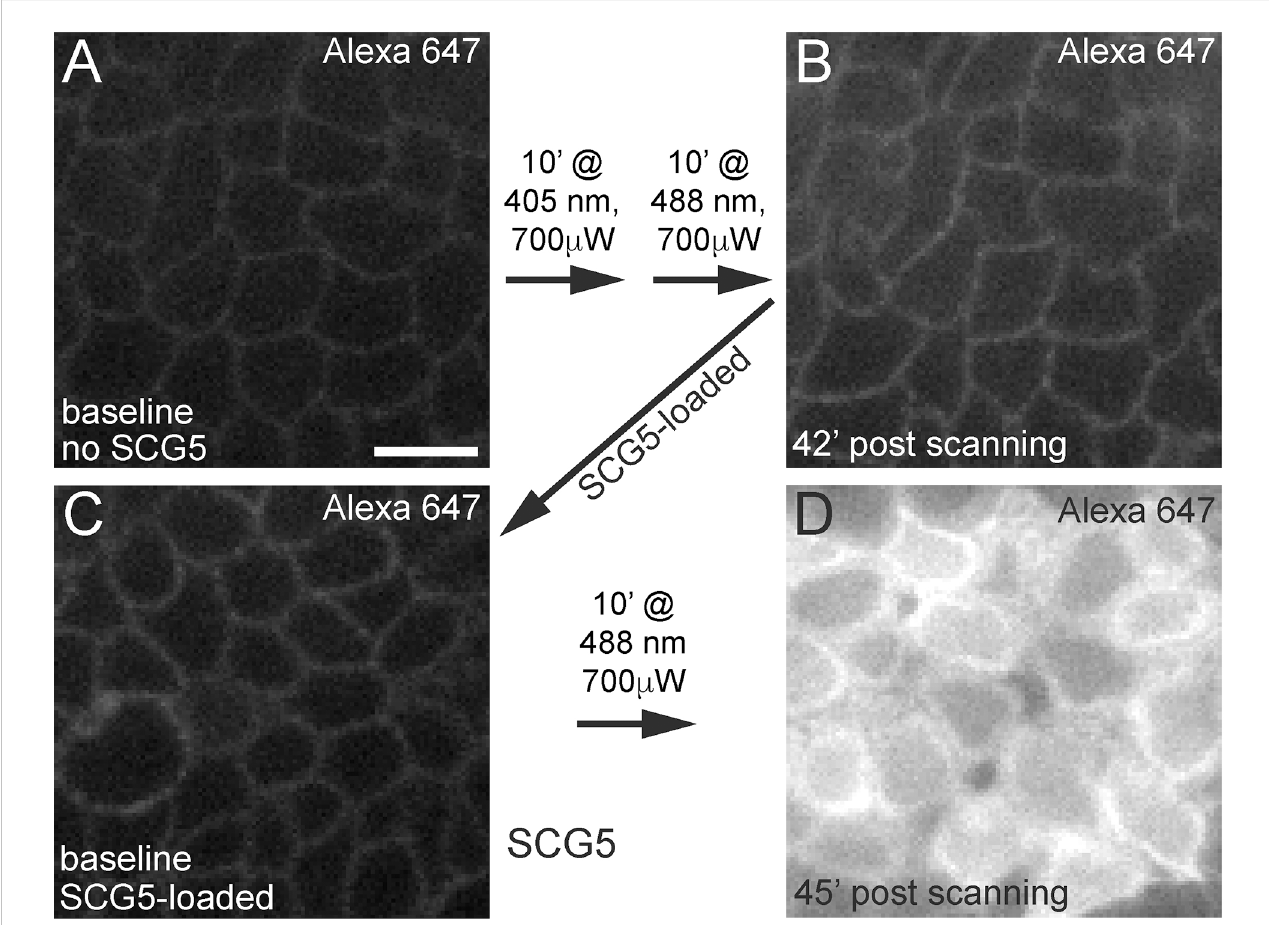
FIGURE 5 Confocal laser scanning-induced corneal microdamage is dependent on SCG5. Alexa 647 hydrazide injected eyes in the absence (A, B) or presence (C, D) of SCG5 were subjected to the wavelengths, laser powers and durations indicated on the arrows. At all other times, imaging was performed using the 640 nm laser line set at <5% laser power. (B) Scanning for 10 ’ at 405 nm (80% laser power setting, 225 m W) followed by another 10 ’ at 488 nm (80% laser power setting, 700 m W) did not lead to robust Alexa 647 hydrazide uptake or cell swelling 42 ’ after high power scanning. (D) Following SCG5 injection and scanning for 10 ’ at 488 nm (700 m W), robust Alexa 647 hydrazide uptake was observed. Scale bar =